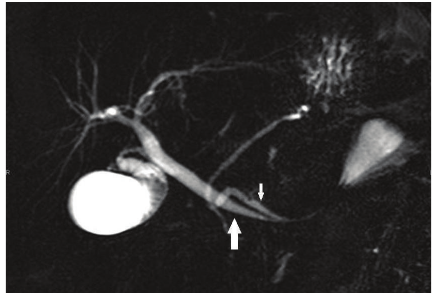
Figure 4: MR Cholangiopancreatography reveals that the common bile duct (large arrow) and the main pancreatic duct (small arrow) are pulled down and leftward into the elongated duodenum.